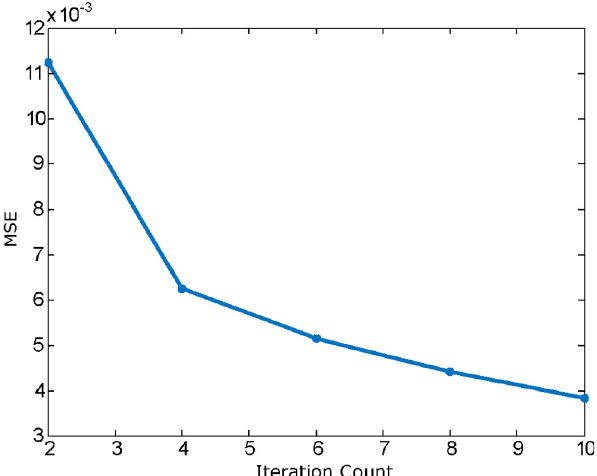
Fig. 19 Error (MSE) as a function of training iterations with varying training time and the same rendering time (30 minutes) for the Candle scene.